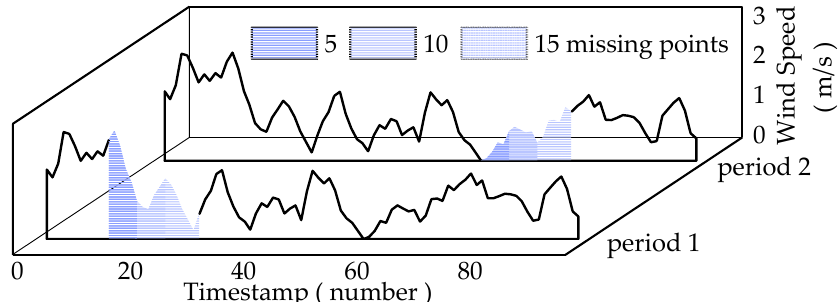
Figure 11. Selected two periods where data are missing. Table 6. Comparison of single-farm and wind farm cluster performance in different conditions of missing data *.